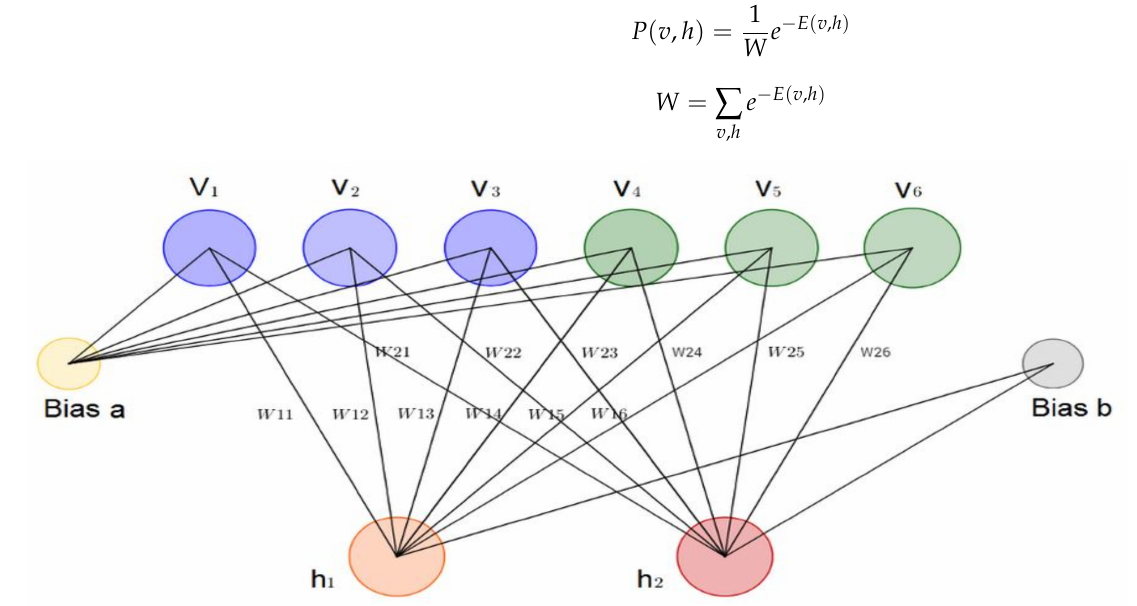
Figure 4. Restricted Boltzmann Machines